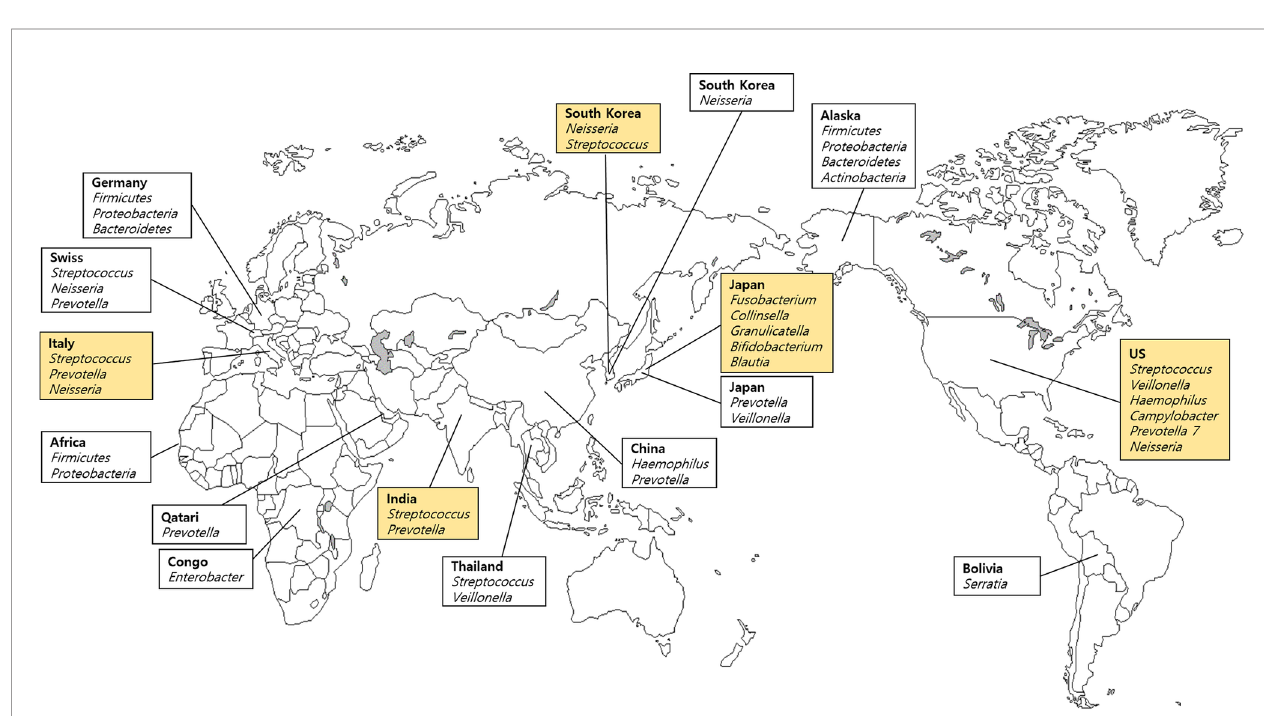
FIGURE 2 | Dominant bacteria in saliva samples based on the Forensic Microbiome Database (www.fmd.jcvi.org) data and non-FMD studies. The yellow-colored box is from the FMD data, and only bacteria which account for over 10% are shown. Five countries from the FMD and 11 countries from previous studies were included, and the microbiome pro fi ling was generated using 16S rRNA gene